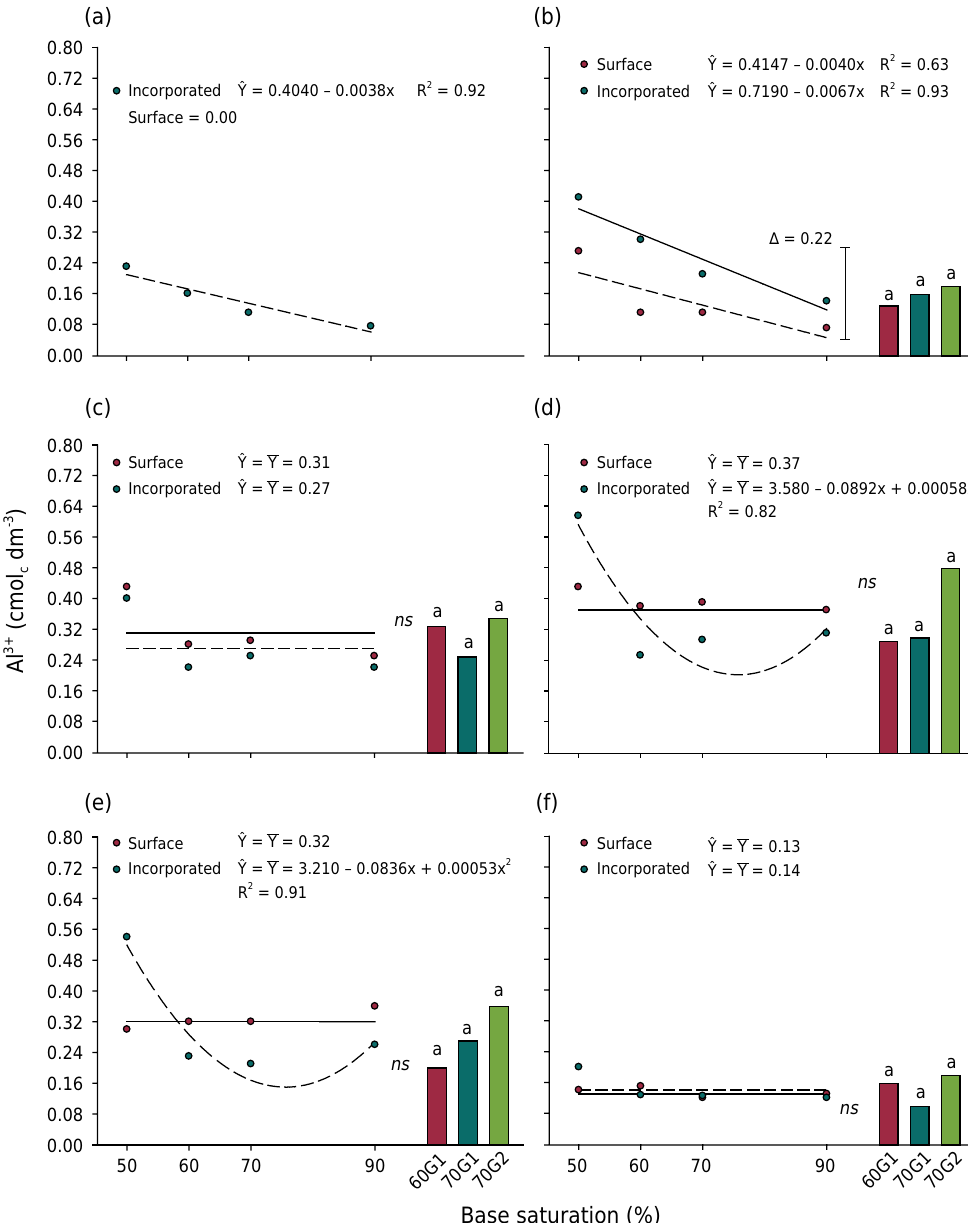
Figure 2. Soil aluminum (Al 3+ ) content in the 0.00-0.05 (a), 0.05-0.10 (b), 0.10-0.20 (c), 0.20-0.30 (d), 0.30-0.40 (e), and 0.40-0.60 m (f) layers 48 months after treatment. Soils were limed to different base saturation (BS) levels (50, 60, 70, and 90 %) by surface application (SL) or lime incorporation (IL) or treated by surface application of lime (60 and 70 % BS) and a standard (G1) or double (G2) dose of phosphogypsum as 60G1, 70G1, and 70G2. Different letters above columns indicate significant differences between phosphogypsum treatments (Tukey’s test, p<0.05). Vertical bars represent least significant differences between treatments (Dunnett’s test,